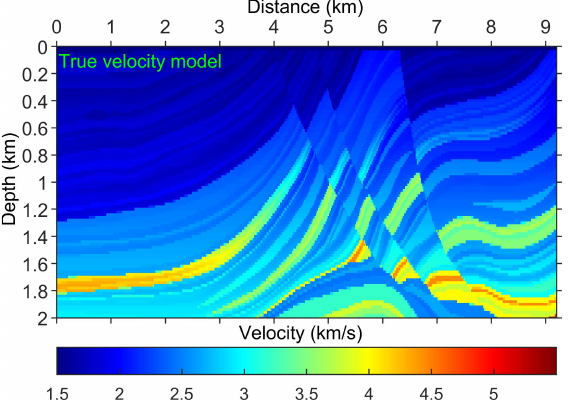
Figure 12. Marmousi velocity model